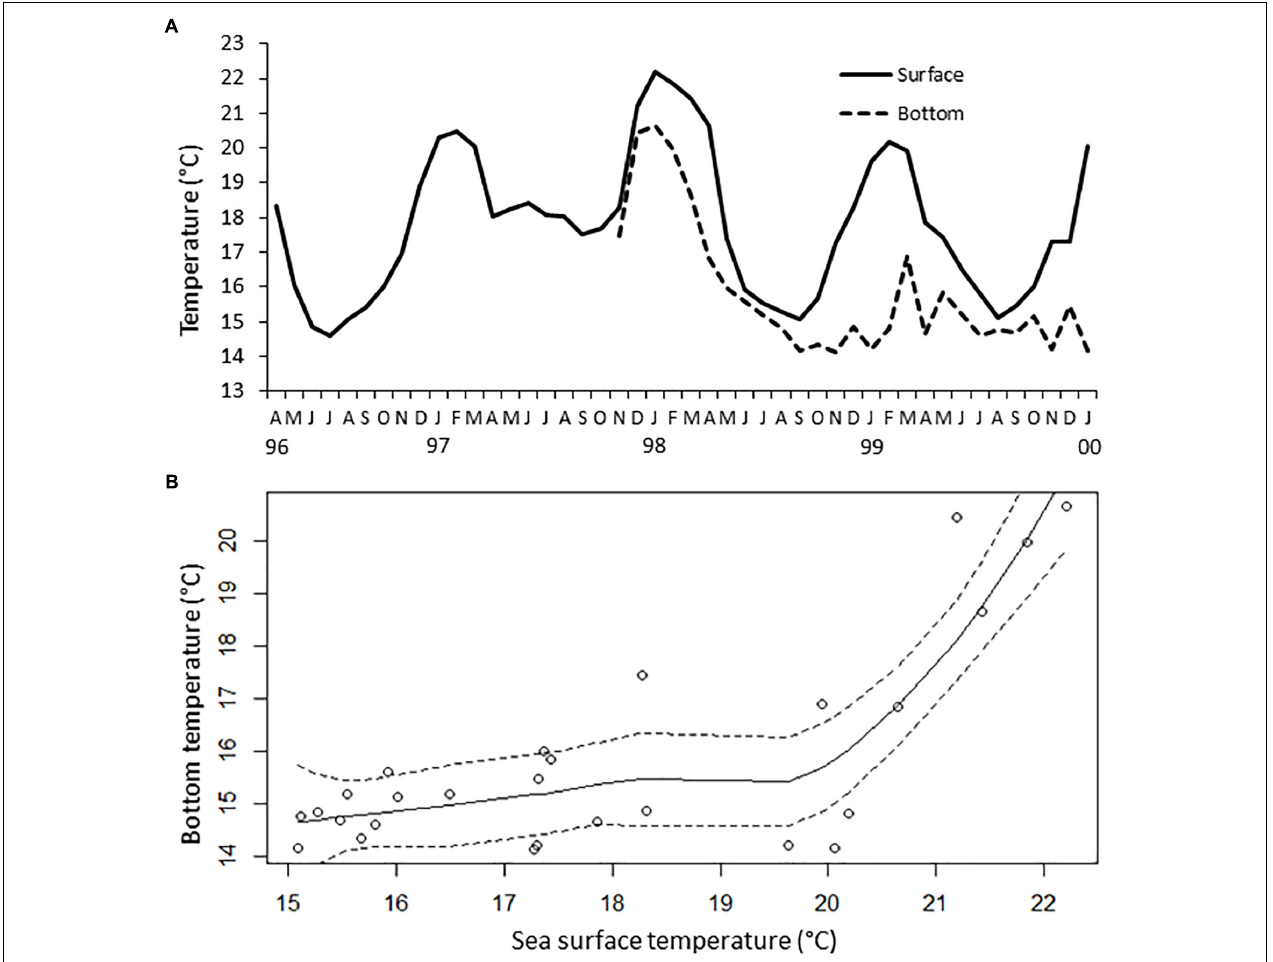
FIGURE 4 | Thermal variability of sea surface and bottom temperature in Antofagasta Bay. (A) Time series of sea surface temperature in a meteorological station in Antofagasta Bay and bottom temperature (16 m) in the sampling area at La Rinconada Marine Reserve (see Figure 1 ); (B) LOESS (Locally estimated scatterplot smoothing) regression of the relationship between sea surface temperature and bottom temperature in the sampling area (spam argument: 2/3; dashed lines represent 95% confidence